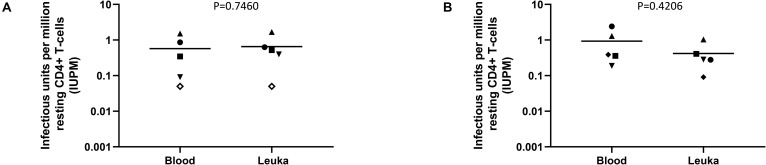
Comparison of the DEVO assay using resting CD4 + T cells isolated from whole blood vs leukapheresis product (Leuka). (A) Targets (either PHA blasts or MOLT4/CCR5) added to expand virus. (B) No targets added. Whole blood was collected 6–17 months from leukapheresis donation time. Each symbol represents an independent assay performed using cells from 4 distinct participants (DV-02, DV-03, DV-04, DV-09 and DV-11). For each experiment, cultures either received exogenous targets to expand virus or no targets. Open symbols indicate values below the limit of detection. The Mann–Whitney U test was used to compare statistical differences.